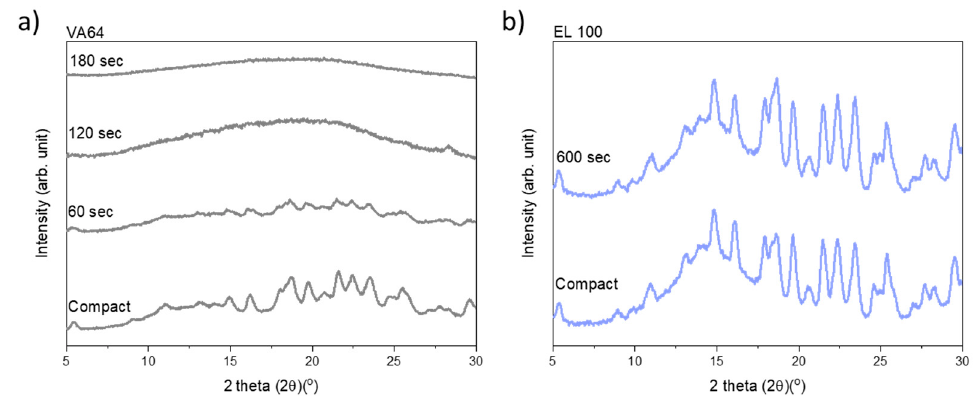
Figure 2. Diffractograms of the compacts before and after different exposure times to laser radiation: ( a ) VA64 compacts (dark grey); ( b ) EL100 compacts (blue).